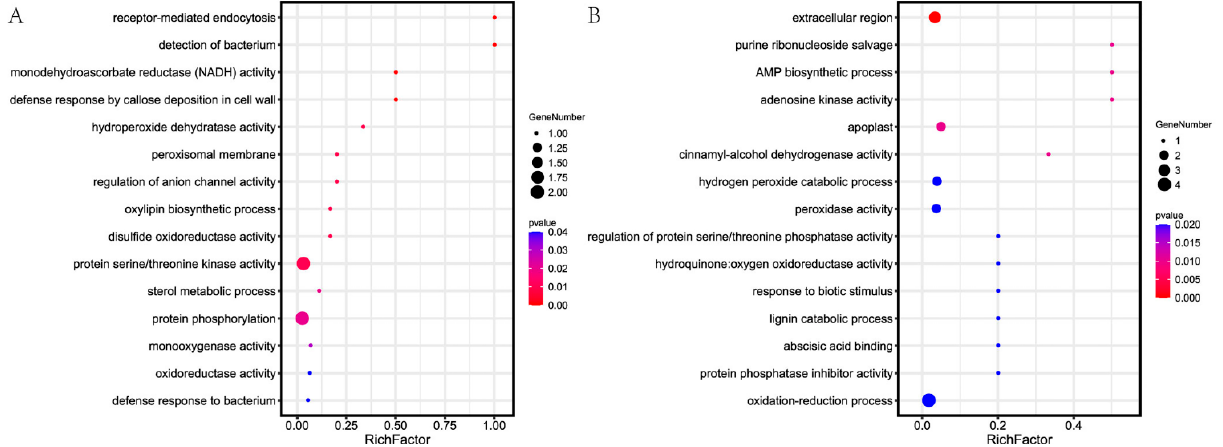
Figure 3. GO enrichment analysis of associated DEPs and DEGs. ( A ) GO enrichment analysis of line 8723 in response to salt stress; ( B ) GO enrichment analysis of P138 in response to salt